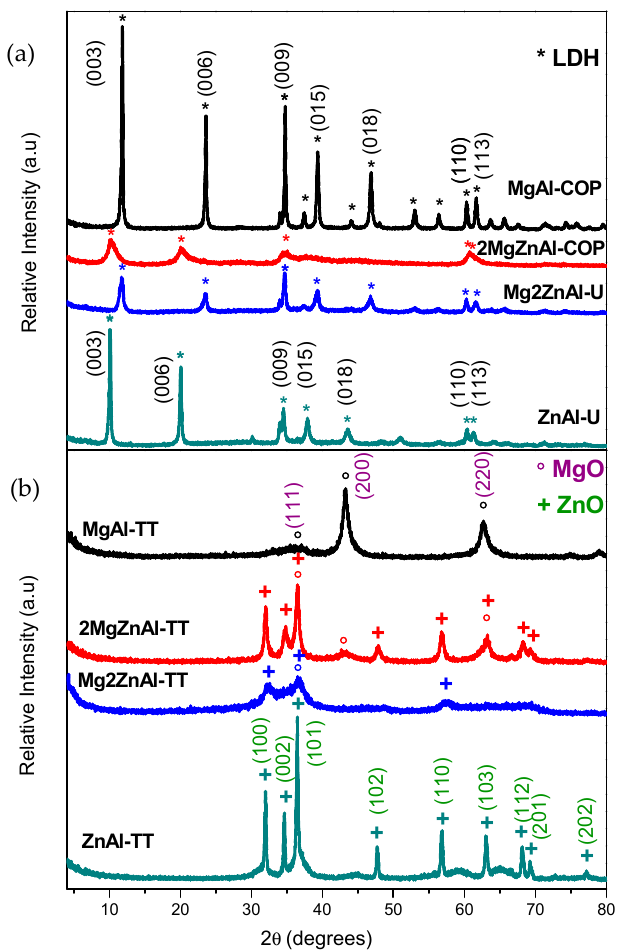
ff raction patterns of: ( a ) as-prepared, and ( b ) calcined Figure 2. X-ray diffraction patterns of: ( a ) as-prepared, and ( b ) calcined samples. Figure 2. X-ray di